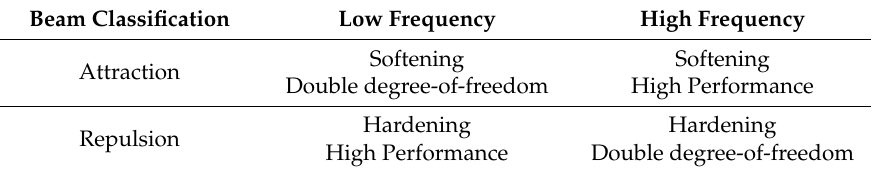
Table 2. Summary of different model features.